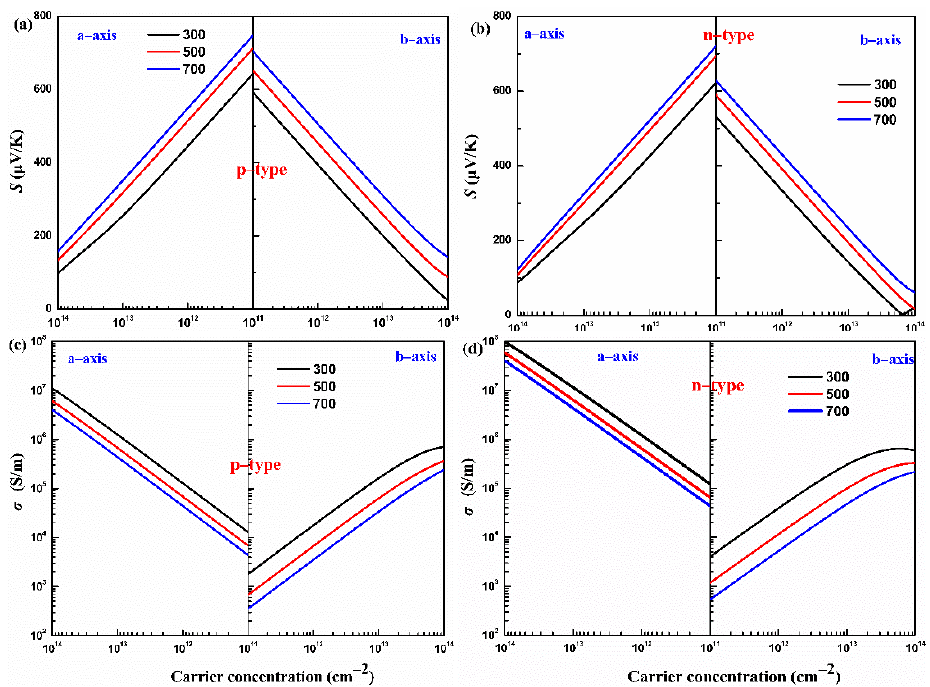
Figure 5. The calculated Seebeck coefficient ( S ) ( a , b ) and electrical conductivity ( σ ) ( c , d ) of the monolayer Hf 2 Br 4 at various temperatures (300, 500, and 700 K, respectively). Table 1. The calculated deformation potential constant 𝐸 1 , elastic constant C and effective mass m * ( 𝑚 𝑒 is the electronic mass) for Hf 2 Br 4 . The relaxation time τ at 300 K is listed together.